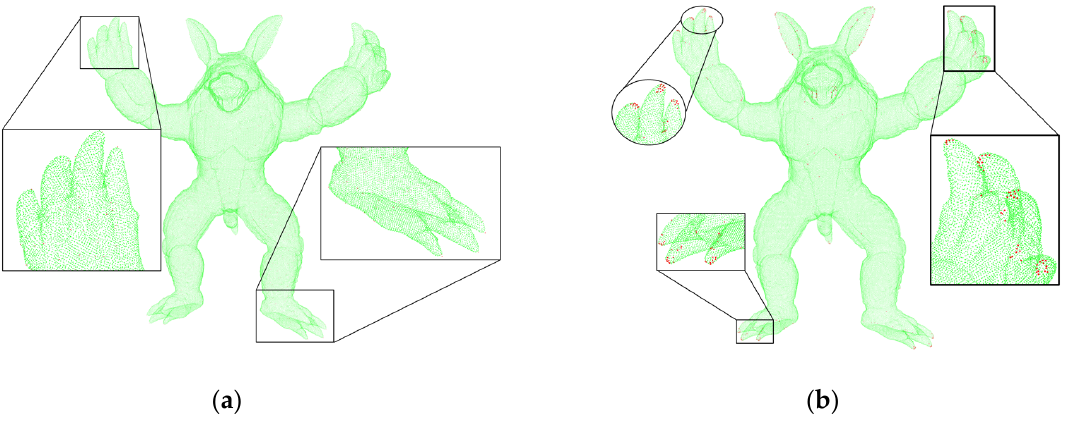
Figure 7. Feature point extraction. ( a ) 3D ‐ Harris extraction. ( b ) Text semantic extraction.